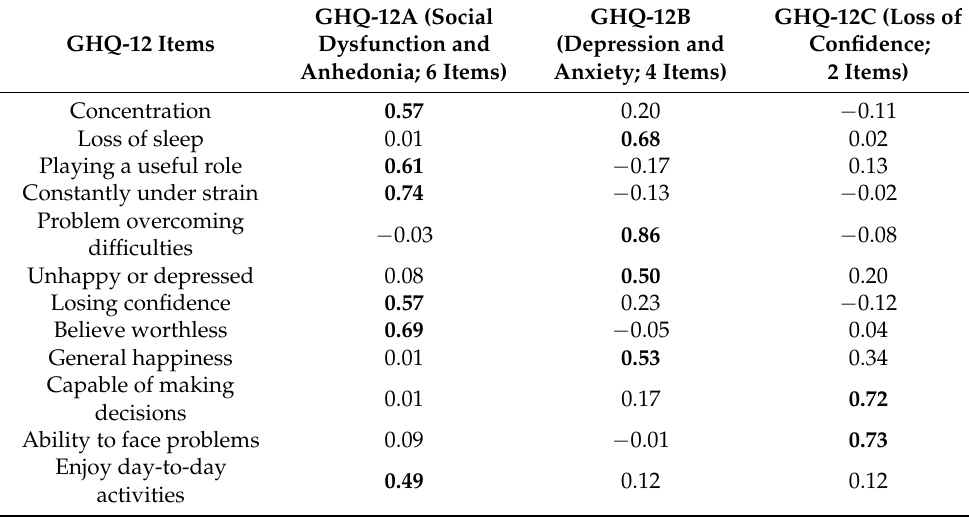
Table 3. The current study found that arthritis patients have poor overall mental health as indicated by the GHQ-12 summary score (t(5587) = 21.17, p < 0.001, Cohen’s d = 0.31, 95%